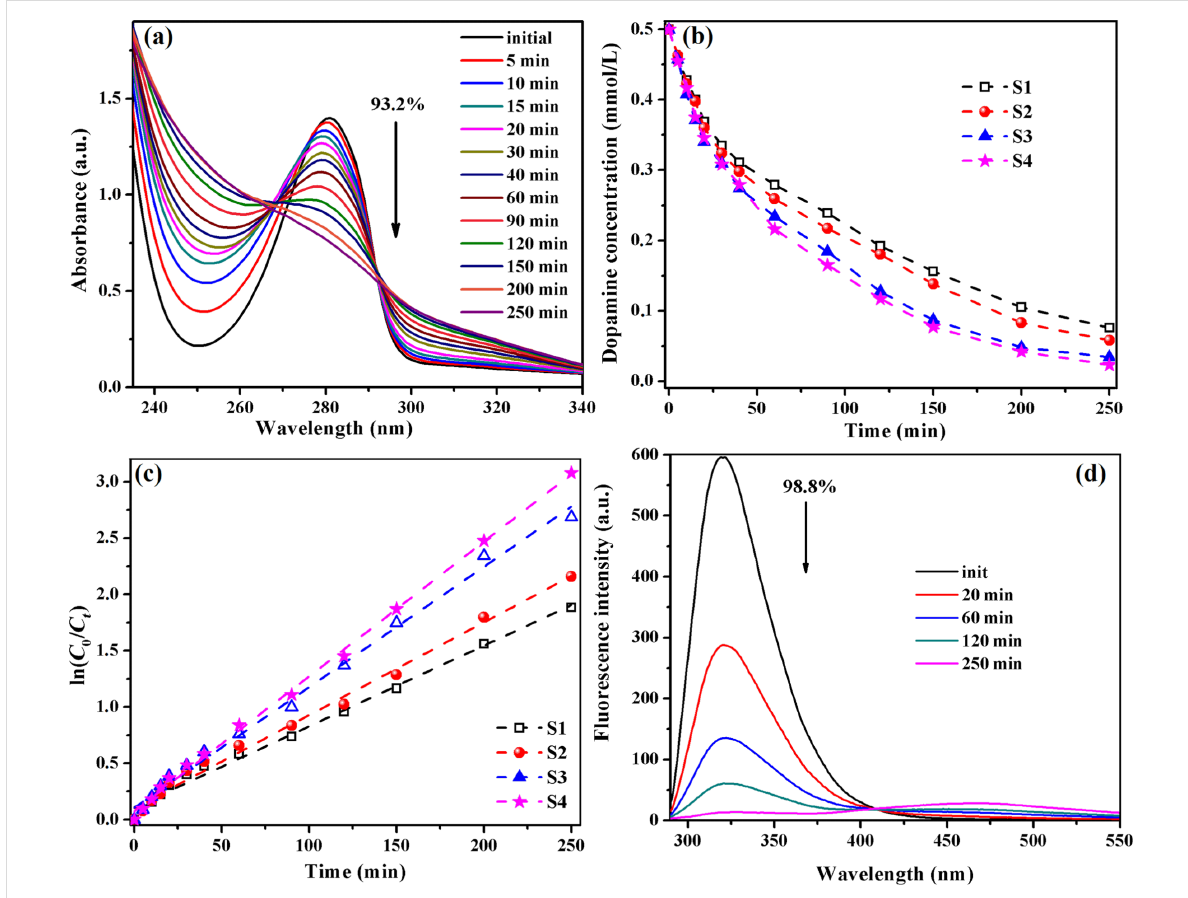
Figure 10: Changes of UV–vis absorption spectra of an aqueous dopamine solution in the presence of S3 as a function of the UV irradiation time (a); temporal evolution of the dopamine concentration (b) and fitted curves for the kinetic estimation of dopamine photodegradation (c) in presence of composites S1–S4; fluorescence spectra of aqueous dopamine solution in the presence of S4 as a function of the UV irradiation time (d).